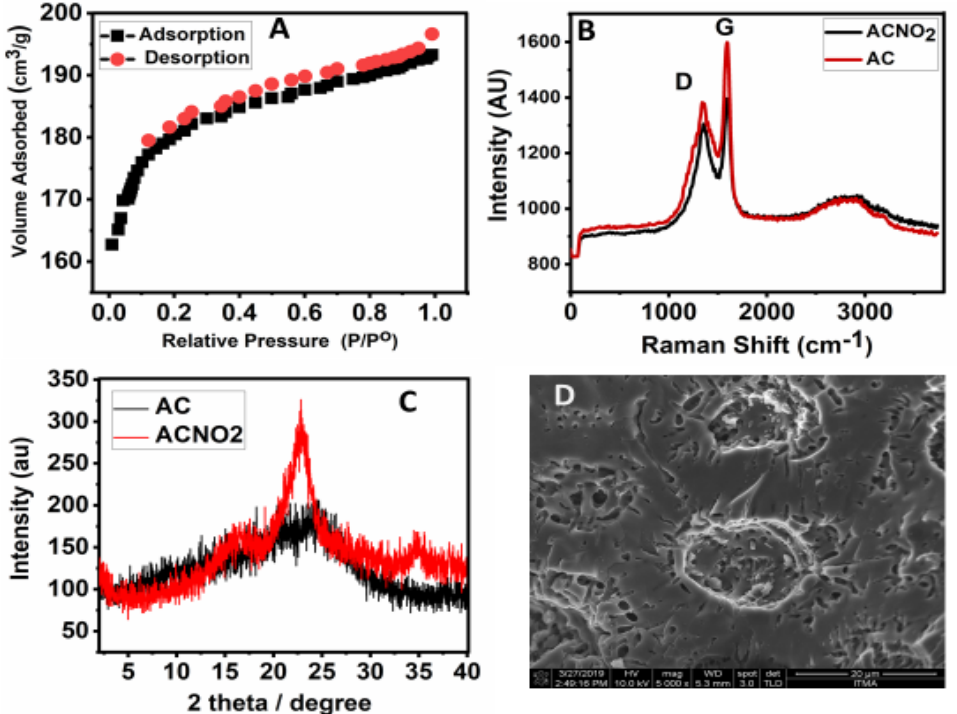
Figure 2. Adsorption—desorption isotherm of FAC ( A ), Raman spectroscopy of AC and FAC ( B ), XRD diffraction patterns of AC and FAC ( C ) and a FESEM micrograph of FAC ( D ).